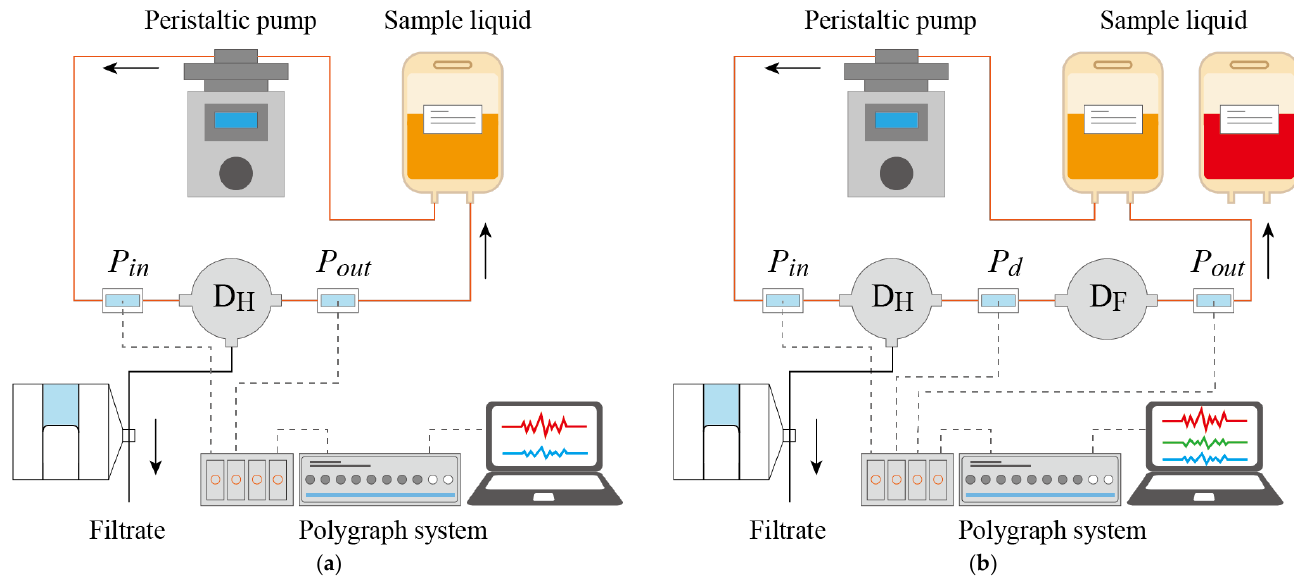
Figure 5. Perfusion system for in vitro experiments with D H alone ( a ) and with D H and D F ( b ). Pressures at the inlet and outlet of the device are measured with pressure transducers and a polygraph system. Pressure and flow rate are controlled with the peristaltic pump, while the tubes can be clamped or opened to ambient conditions.